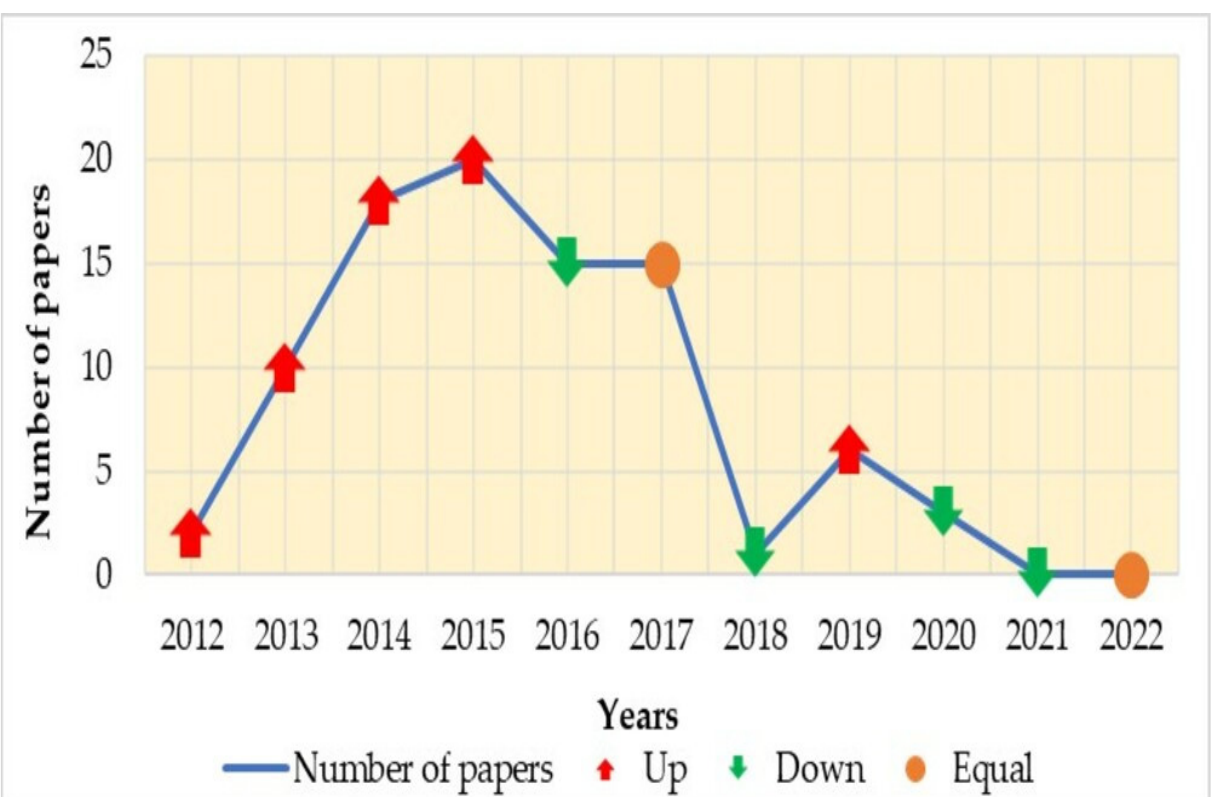
Figure 3. The top 100 most cited YIG papers during the last ten years.